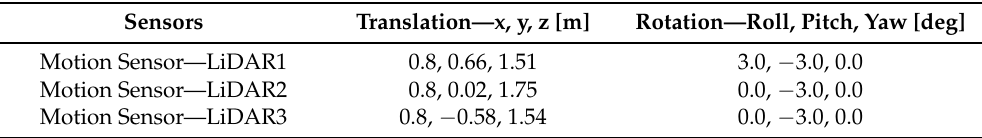
Figure 9. ( a ) The outdoor parking lot used for data acquisition; green line represents trajectory of the vehicle. ( b ) Autonomous vehicle platform of Konkuk University used for data acquisition. Table 6. Calibration parameter between one motion sensor (IMU) and three LiDARs (LiDAR1: Top-left LiDAR, LiDAR2: Top-mid LiDAR, LiDAR3: Top-right LiDAR) on the the vehicle.